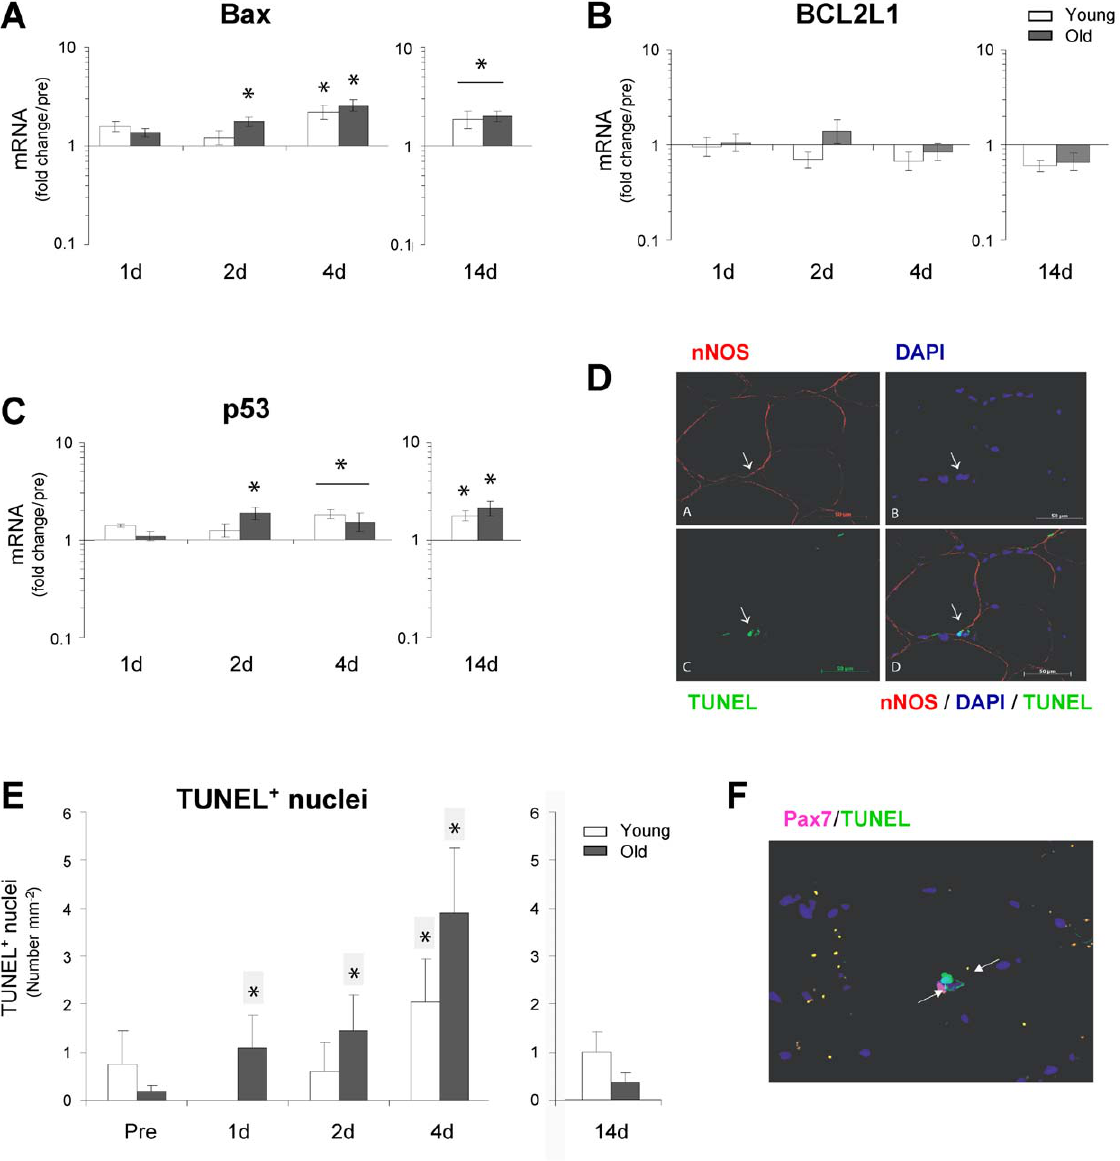
Figure 8. Immobility increases the transcriptional status of Bax, BCL2L1 and p53 and the immunodetection of TUNEL. A–C . The mRNA level of Bax, BCL2L1 and p53 was determined using qRT-PCR and significant increases were found in the early phase (0–4 days) as well as later phase (14 days) of disuse-muscle atrophy D. Skeletal muscle cryosections were immunostained for nNOS (red), DAPI (blue) and TUNEL (green). E. Total numbers of TUNEL-positive nuclei were quantified for both young and old muscle and significant increases of TUNEL-positive nuclei were detected in old muscle in the early phase of immobility (1–2 days) and in both young and old after 4 days of immobility. F. Double immunohistochemical staining for TUNEL and the muscle satellite cell marker Pax7 did not reveal any TUNEL-positive muscle satellite cells. Additional green fluorescent expression on the shown image is due to autofluorescence by lipofusin and this is considered non-specific in our analysis. *Time effect, p , 0.05 compared to pre. * Time effect, p , 0.05 bar indicates young and old combined compared to pre. Data are means 6